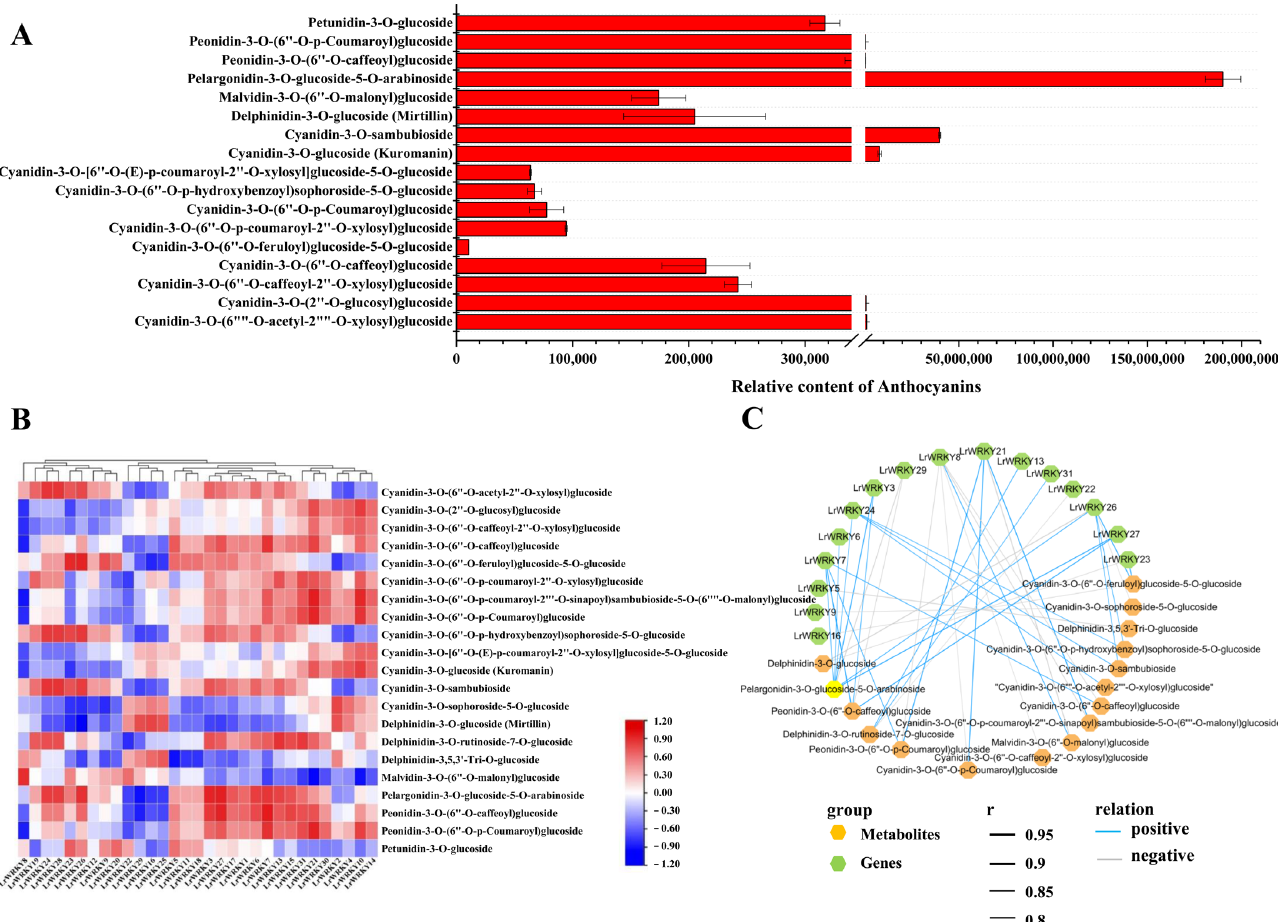
Figure 7. The regulatory network of key anthocyanins metabolites and LrWRKY genes in L. radiata. ( A ) Eighteen anthocyanins were identified and quantified from petals of L. radiata. ( B ) The Pearson’s correlation coefficients of LrWRKYs with an anthocyanin biosynthesis pathway in L. radiata . Higher values are represented by red, whereas lower values are represented by blue. ( C ) Correlation network of metabolite-related LrWRKY genes involved in anthocyanin biosynthetic pathways. r represents the Pearson correlation coefficient; relation represents the correlation, including positive (r > 0.8) and negative correlations (r < −